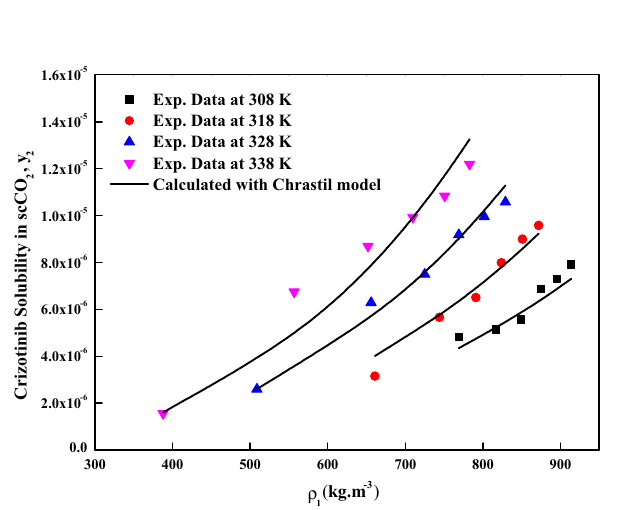
Table 4. Standard solubility models parameters.